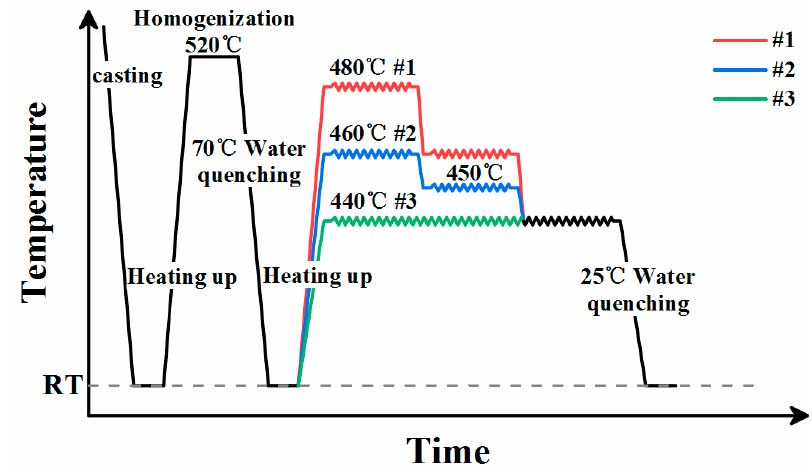
Figure 2. The schematic illustrations of experimental procedures for sample #1, #2 and #3.